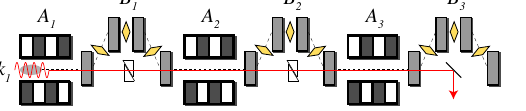
FIG. 1. Triple modulator and chicane layout. The timing of single laser in each section can be adjusted by adjustable phase delay. Variable quadrupoles between bends in the chicanes (yellow diamonds) permits reversal of the sign of the momentum